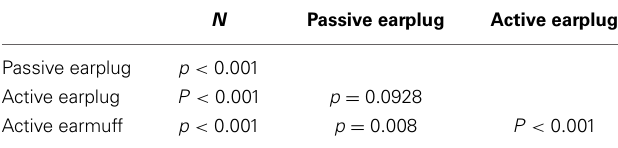
Table 5 | Results of pairwise comparisons between the different test conditions for different types of HPDs for front-back confusions.